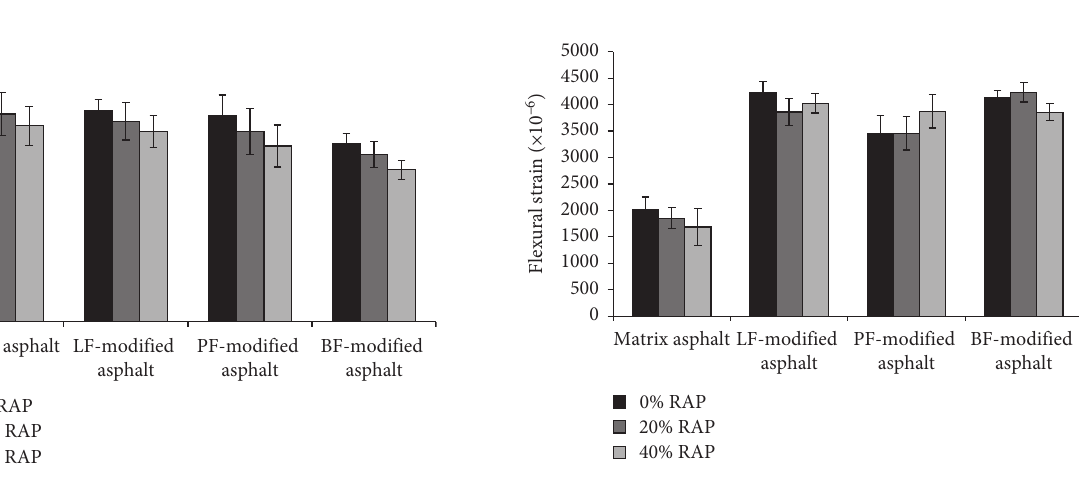
Figure 4: Rut depth results of different asphalt mixtures.